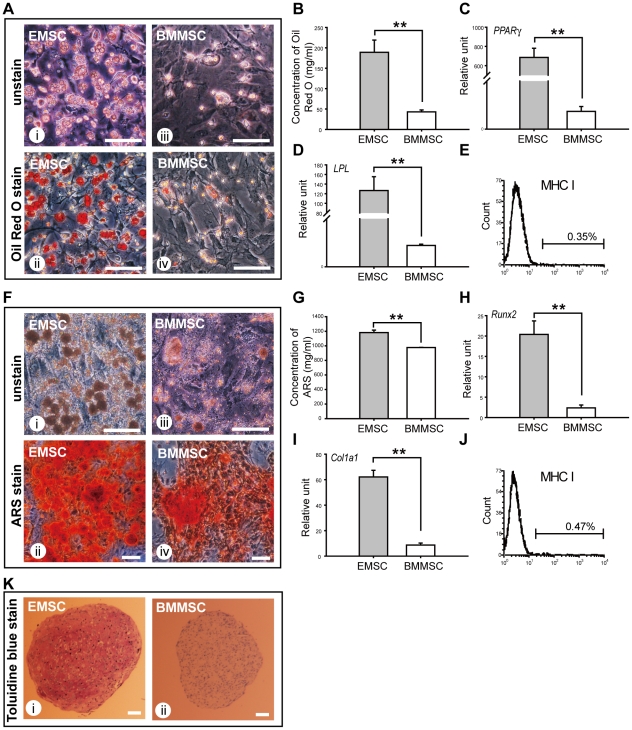
Differentiation potential of EMSCs and BMMSCs.(A) Adipogenic differentiation of EMSCs and BMMSCs at the fifth passage. Adipogenic capability was characterized by Oil Red O staining after seven days induction. EMSCs showed larger and more lipid drops than BMMSCs. (B) Oil Red O staining of EMSCs and BMMSCs were quantified for comparison (n = 3). (C, D) Expression level of adipogenic related genes were assessed by qPCR. EMSCs showed higher adipogenic gene expression level after seven days induction (n = 3). (E) MHC I expression profile of EMSCs was analysed by flow cytometry after seven days adipogenic induction. After adipogenesis, EMSCs were still negative for MHC I expression. (F) Osteogenic differentiation of EMSCs and BMMSCs at the fifth passage. Osteogenic capability was characterized by ARS staining after seven days induction. EMSCs showed higher calcium deposition than BMMSCs. (G) Quantitative results of ARS were performed to compare the osteogenic capacity of EMSCs and BMMSCs (n = 3). (H, I) Expression level of osteogenic related genes were assessed by qPCR. EMSCs showed higher osteogenic gene expression level after seven days induction (n = 3). (J) MHC I expression profile of EMSCs was analysed by flow cytometry after seven days osteogenic induction. After osteogenesis, EMSCs were still negative for MHC I expression. (K) Chondrogenic differentiation of EMSCs and BMMSCs at the fifth passage. Chondrogenic capability was evaluated by histological section of micromass pellet cultures after 21 days induction. Glycosaminoglycan content of the pellet was characterized by toluidine blue staining. EMSCs showed deeper purple stained matrix than BMMSCs. All the scale bars represent 100 µm. ** represents P<0.01. Data are presented as mean ± s.d. and analyzed with Student's t-test.